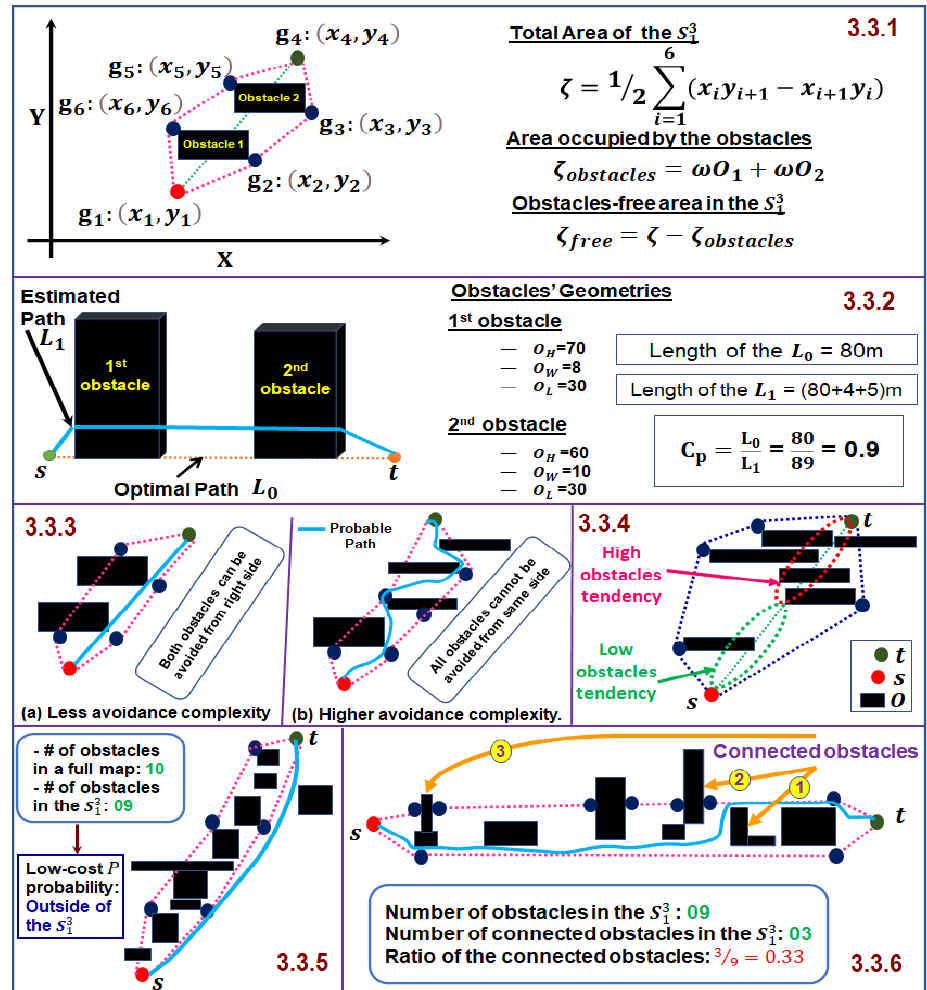
Figure 5. Drawing of the complexity parameters employed to analyze the complexity of the S 3